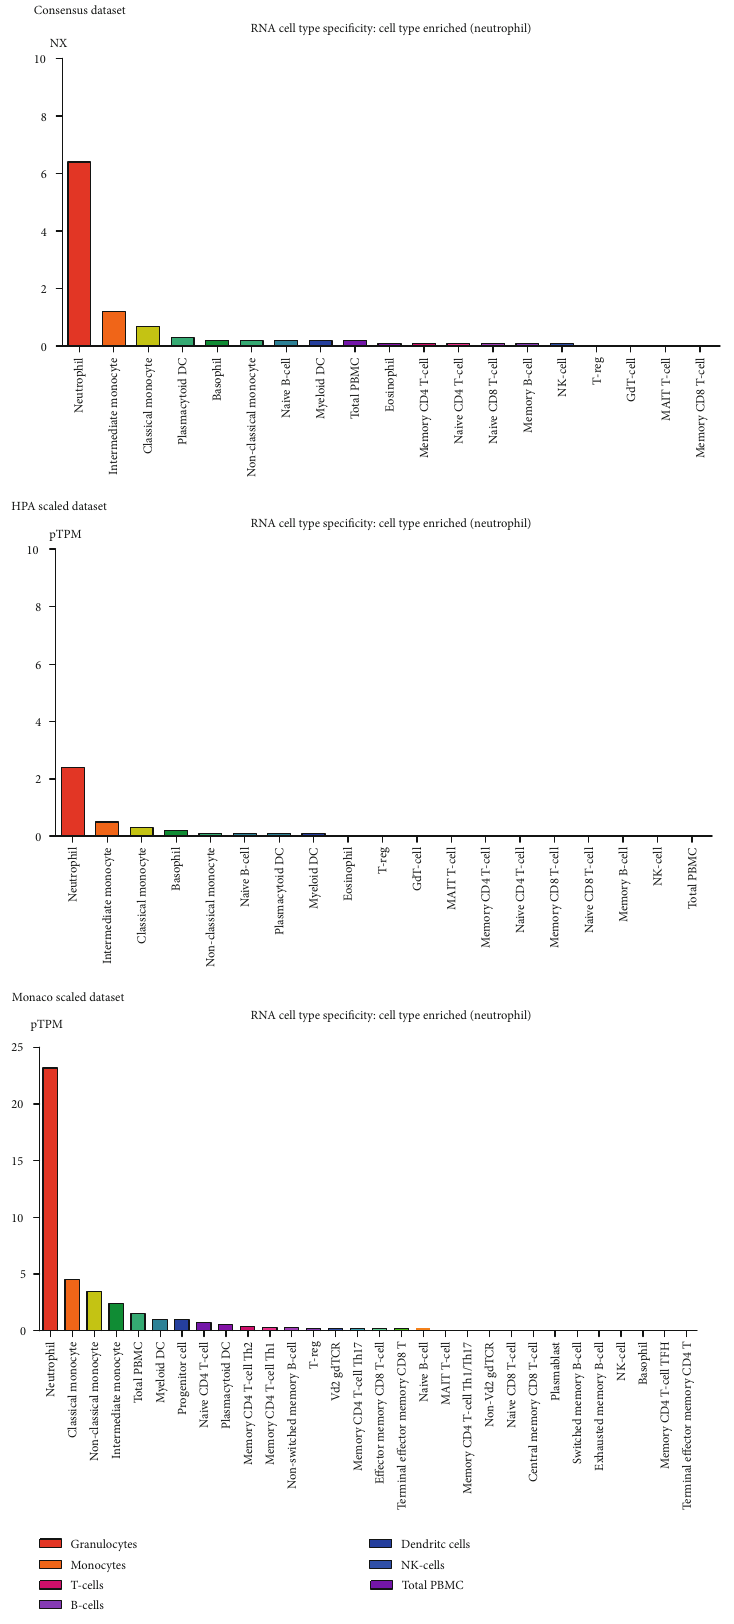
Figure 4: The relative expression of DOCK4 in various cells in peripheral